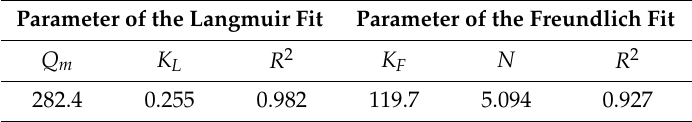
Table 2. Isotherm parameters according to Freundlich and Langmuir fit for RNA adsorption. Parameter of the Langmuir Fit